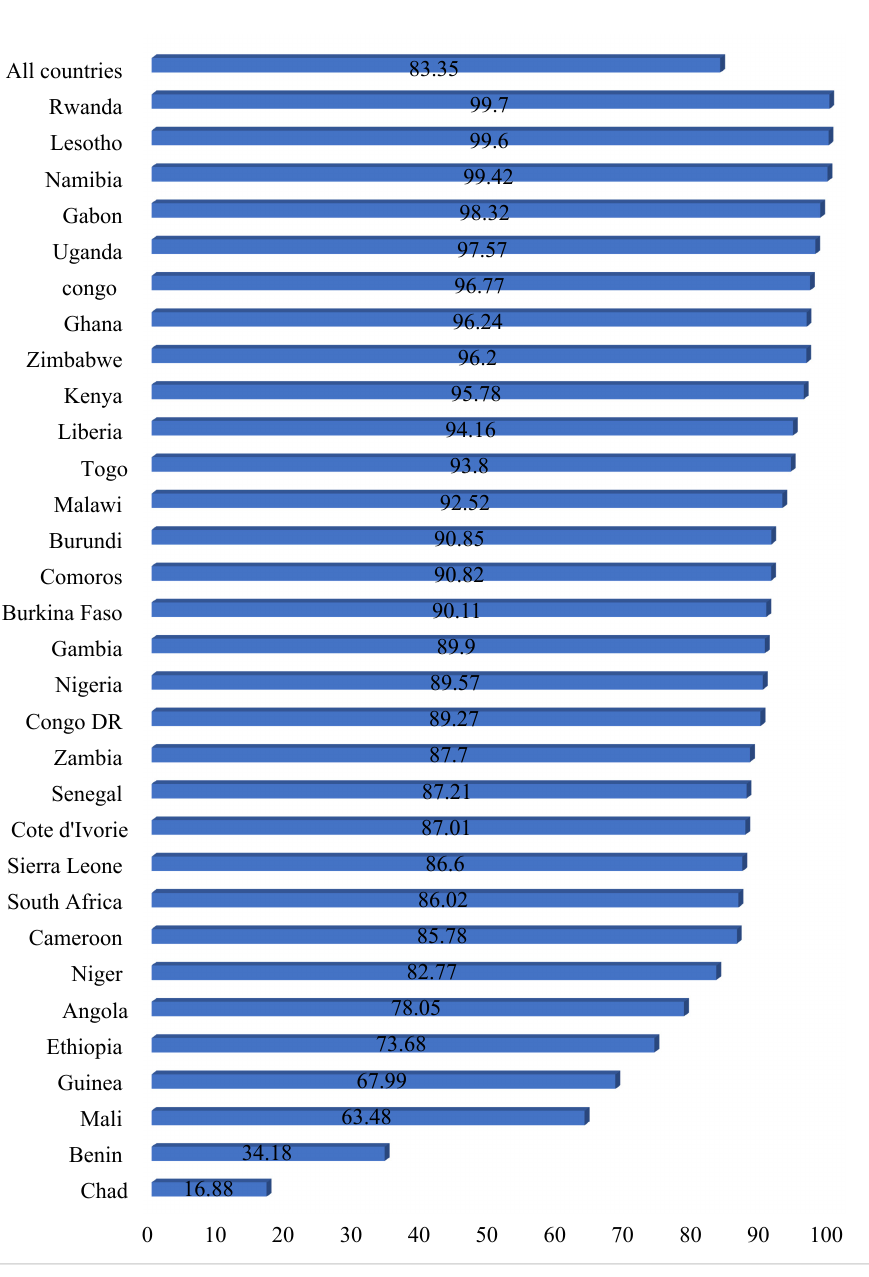
Figure 2. Bar chart showing the proportion of women who have sexual autonomy in sub-Saharan Africa.